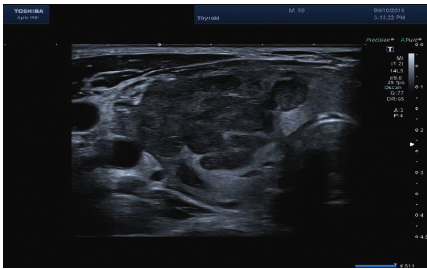
Figure 1: Thyroid ultrasound: linear probe and high frequency. Right lobe: hypoechoic polylobular nodule with intense intra- nodular vascularisation classified as EU-TIRADS 5.